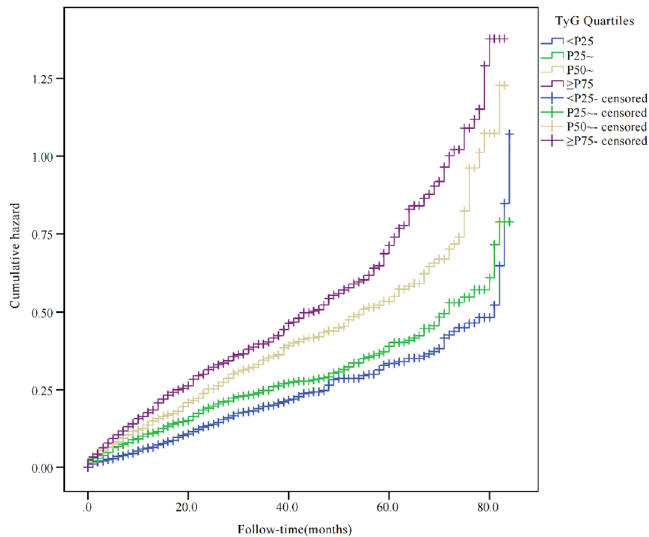
Figure 2. Kaplan–Meier curves for hyperuricemia by TyG quartile: quartile 1 (< 25), < 9.00; quartile 2 (25 ~), 9.00–9.42; quartile 3 (50 ~), 9.42–9.90; and quartile 4 (≥ 75), ≥ 9.90. P value < 0.05 for log-rank test, other quartiles versus first quartile.